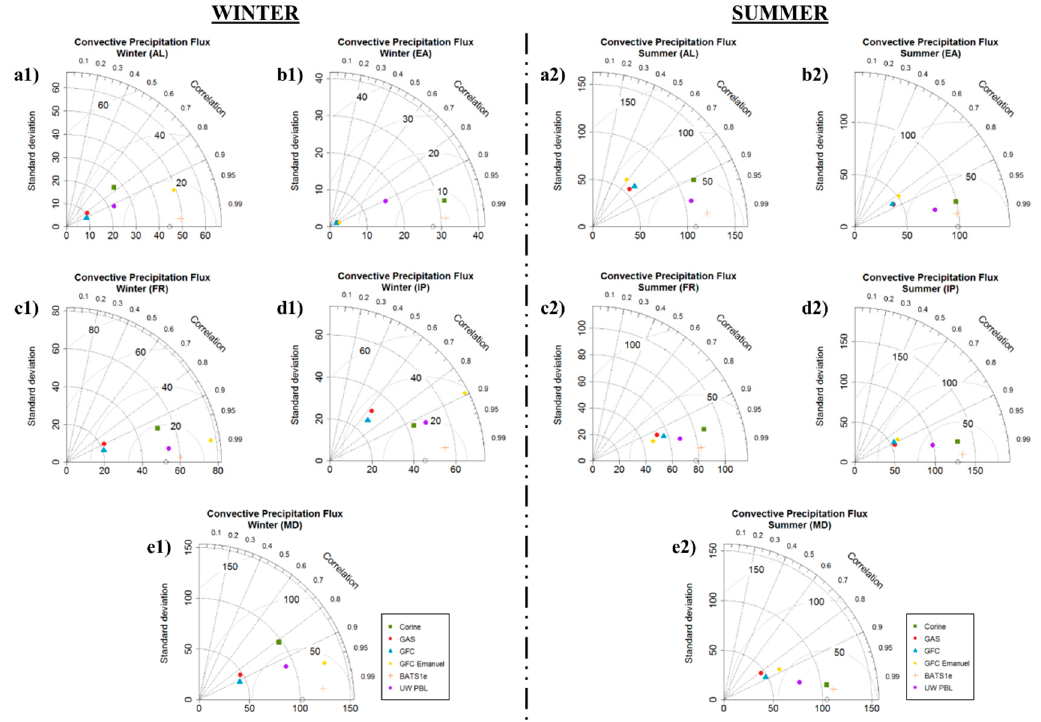
Figure 5. Taylor diagrams exploring the model’s performance for convective precipitation over the five sub-regions (a → AL, b → EA, c → FR, d → IP, e → MD) during winter and summer. The markers in Taylor diagrams represent the different simulations. The default simulation is being used as reference